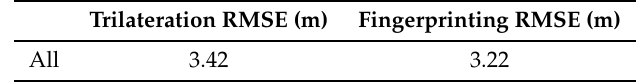
Table 2. Positioning accuracy of trilateration and fingerprinting.